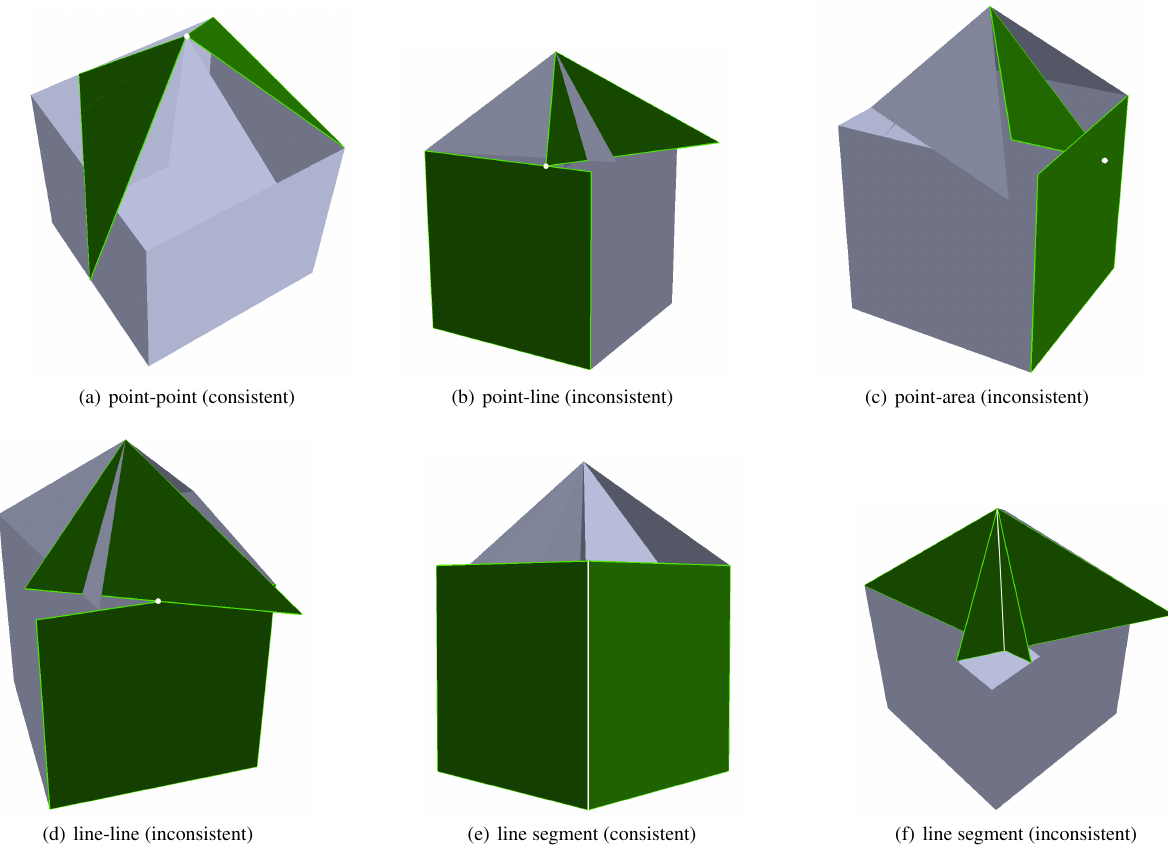
Figure 3. Simple synthetic example of a house with different kinds of topological inconsistencies. The green geometries depict the different types of intersection